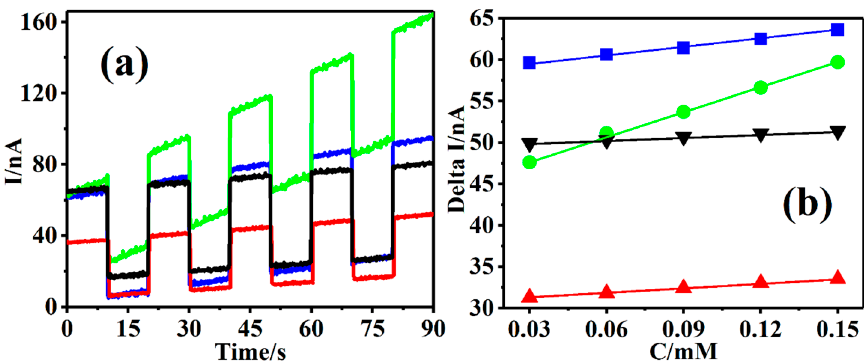
Figure 8. ( a ) Photocurrent responses of Cu-TCPP@MOFs/GCE in different concentrations of AA solution for the addition of 0.015 mM AA each time added 10 μ L in 0.1 M PBS (pH = 7.0) at a 10 s regular time interval under blue light (blue curve), green light (green cure), red light (red curve), and white light (black curve). ( b ) The standard curves of the delta current varying with different concentrations of AA under four light conditions, blue light (blue line), green light (green line), red light (red line), and white light (black line), respectively.